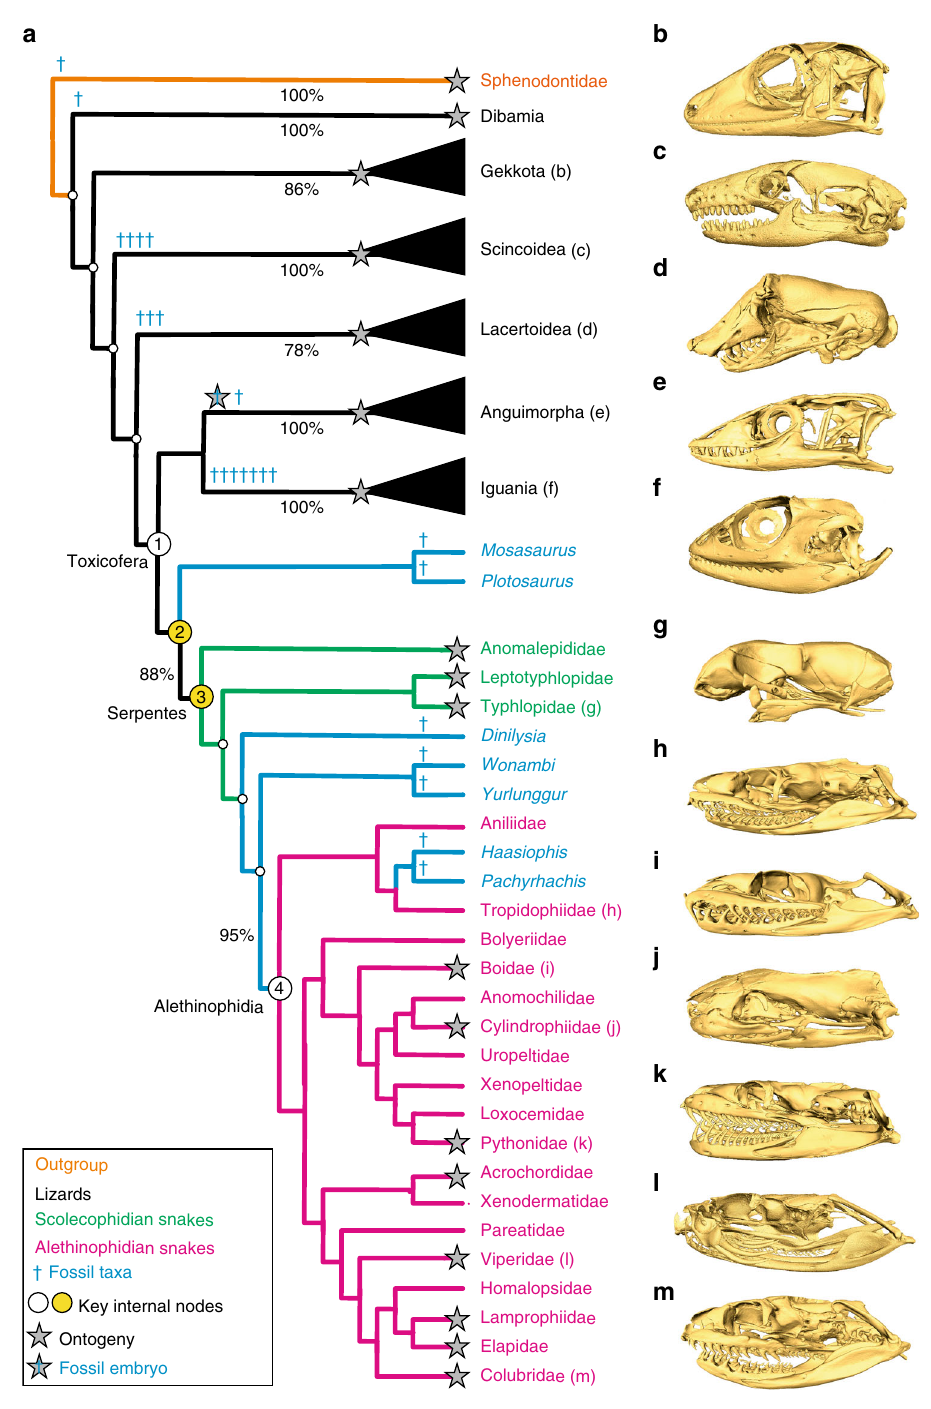
Fig. 1 Phylogeny and skull diversity of squamates. a Simpli fi ed phylogenetic hypothesis used in this study, adapted from the most inclusive and recent molecular 21, 64 as well as combined molecular and morphological phylogenetic studies on squamate evolution 22 – 24 , and rooted using Sphenodontidae (tuatara). Major extant squamate lineages (lizards, black color; scolecophidians, green; alethinophidians, red), tuatara (orange), and fossil genera (blue) are indicated by the same color code throughout the entire manuscript; similarly, the same number code is used for all key internal nodes relative to the origin and diversi fi cation of snakes (1, MRCA of Toxicofera; 2, MRCA of snakes and their sister group; 3, MRCA of crown snakes; 4, MRCA of Alethinophidia). The percent of extant families collected at a particular branch is shown for major lineages. The positions of sampled fossils and ontogenies are indicated by blue crosses and stars, respectively. ( b – m ) 3D-rendered adult skulls of selected representative squamates at indicated position in the phylogenetic tree: Aeluroscalabotes ( b ), Acontias ( c ), Leposternon ( d ), Varanus ( e ), Iguana ( f ), Letheobia ( g ), Tropidophis ( h ), Boa ( i ), Cylindrophis ( j ), Python ( k ), Bitis ( l ), Boaedon ( m